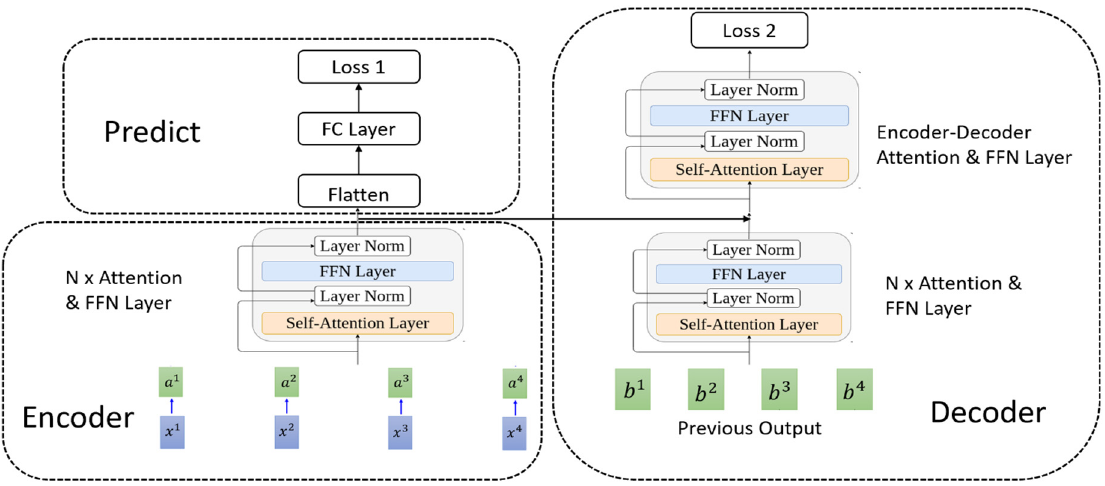
Figure 16. Encoder- Decoder Model Structure. Figure 16. Encoder-Decoder Model